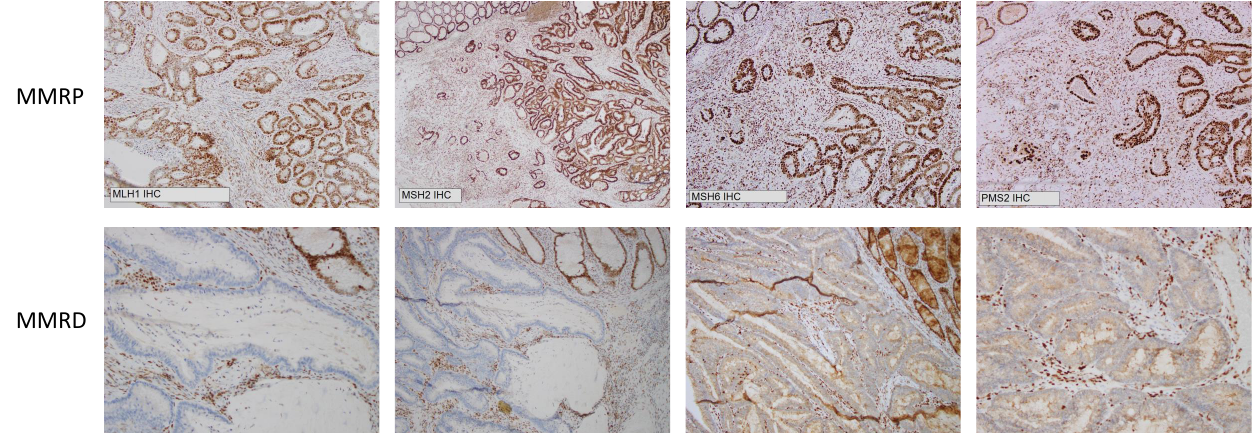
Figure 1. Immunohistochemistry demonstrating mismatch repair proficiency (MMRP) and mismatch repair deficiency (MMRD) at MLH1, MSH2, MSH6, PMS2.